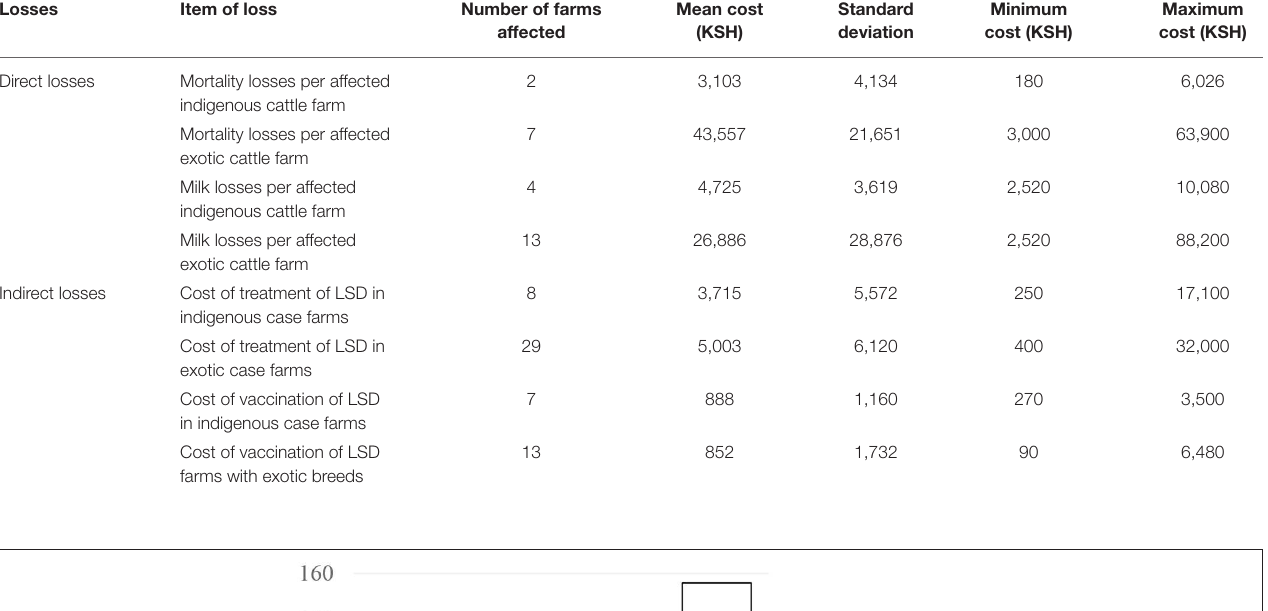
TABLE 3 | Losses incurred by farms due to LSD outbreak in Nakuru County (1USD = 101KSH; two farms having mixed breeds were excluded in this analysis) per farm. Losses